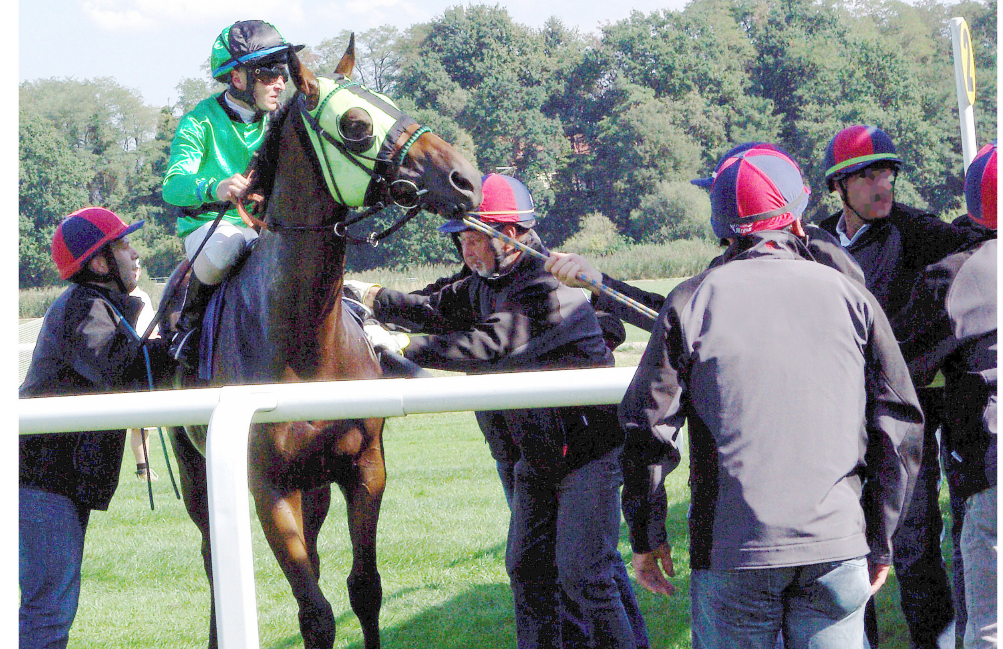
Figure 3. Image 3 for photo-elicitation